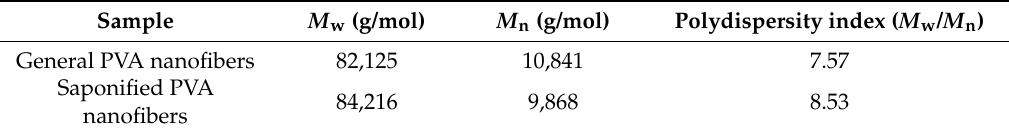
Figure 11. Stress-strain curve of: ( A ) general electrospun PVA nanofibers; and ( B ) fully saponified PVA nanofibers formed by heterogeneous saponification of electrospun PVAc nanofibers. The concentration of these nanofibers was at 15 wt % and the saponification solution was prepared using NaOH (10 g), Na 2 SO 4 (10 g), MeOH (10 g) and H 2 O (100 g). The saponification temperature and time were 25 °C and 30 h, respectively. The DS value of the fully saponified nanofibers was 99.93%.